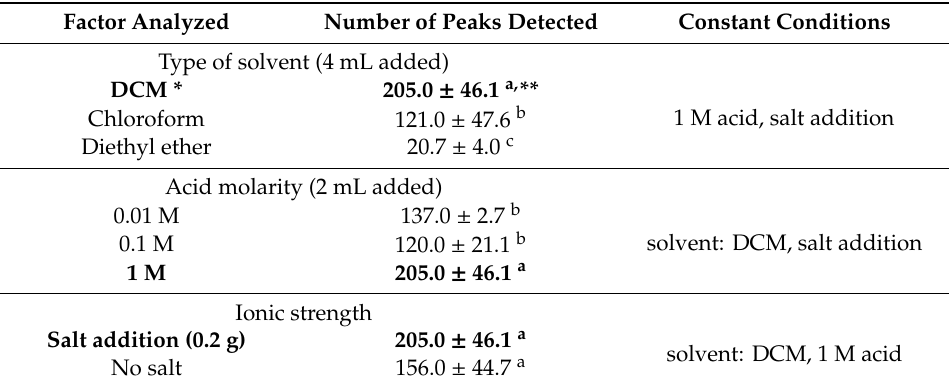
Table 1. Comparison of the factors a ff ecting the extraction e ffi ciency of urine VCs using GC-MS analyses. Values in bold were selected as the most e ffi cient and were used for the optimization of the next